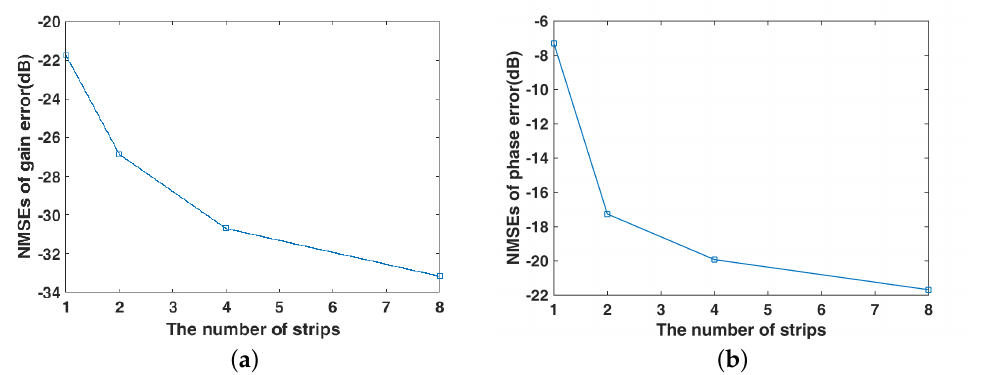
Figure 7. Gain–phase error estimation performance under different strips ( a ) NMSE of gain error estimation; ( b ) NMSE of phase error estimation.